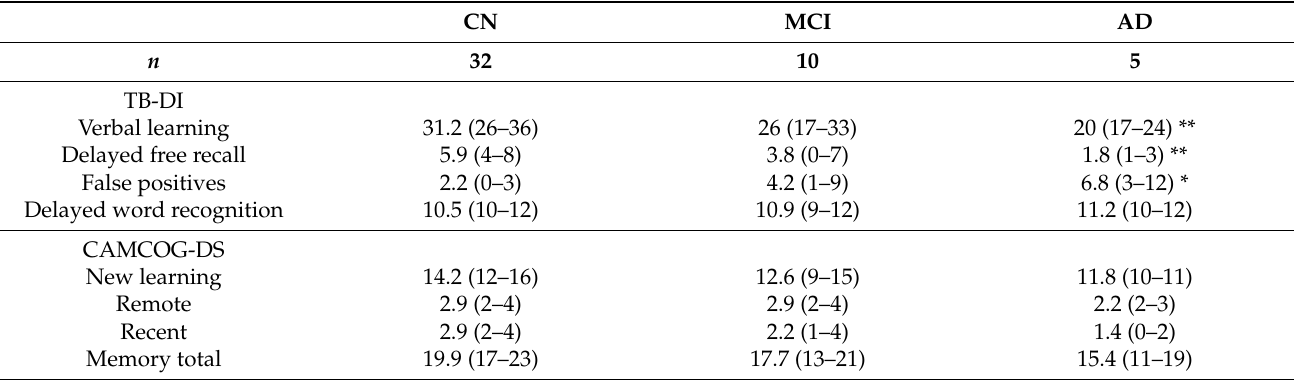
Table 2. Cognitive scores by group for mild intellectual disability